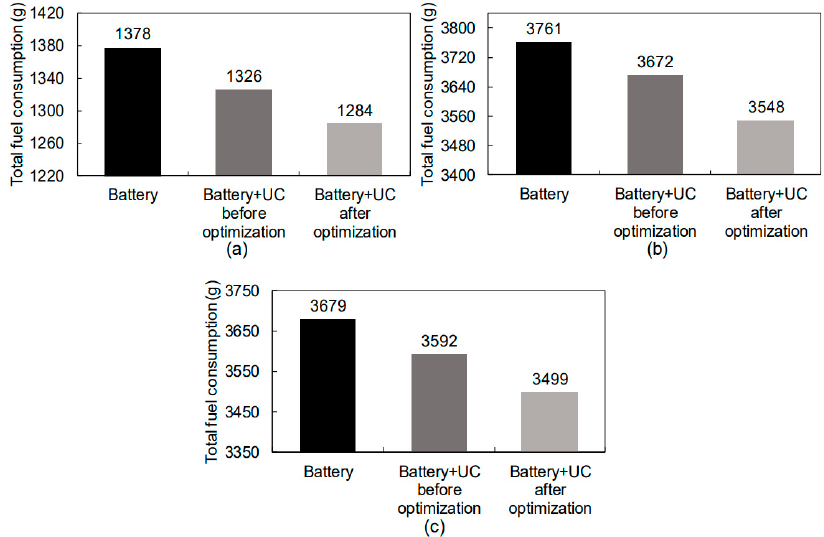
Figure 17. Comparison of total fuel consumption: ( a ) Manhattan cycle; ( b ) Brunswick cycle; ( c ) Or- ange County cycle.